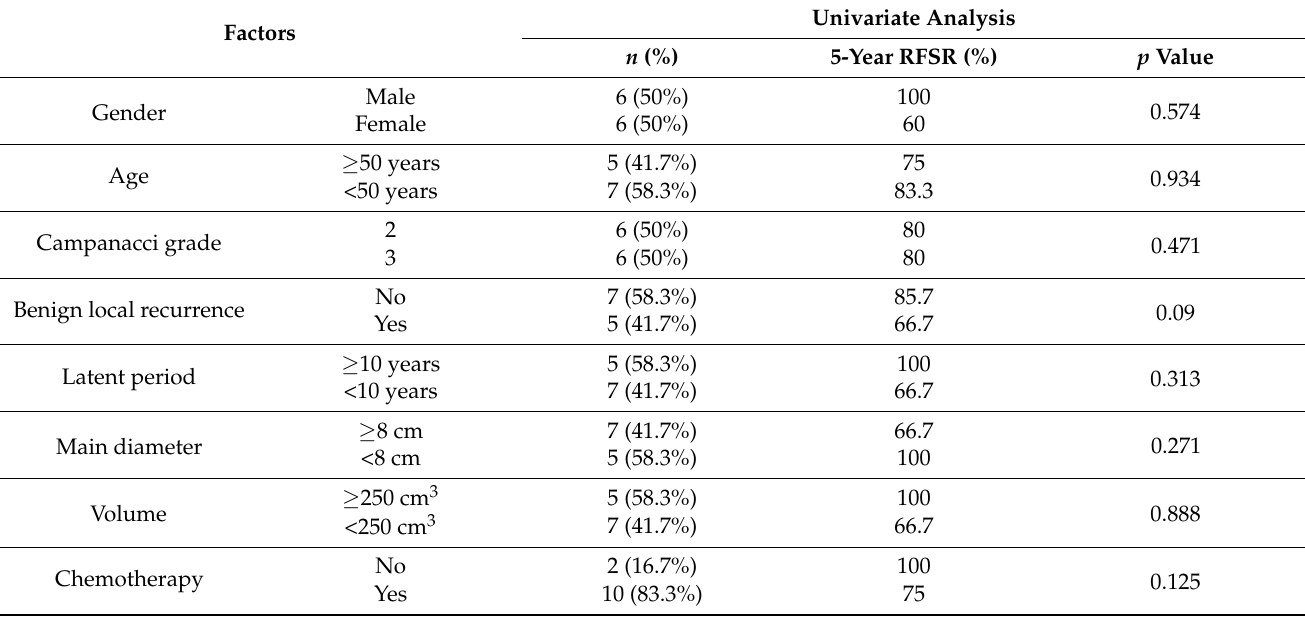
Table 4. Statistical analysis of prognostic factors for local recurrence-free